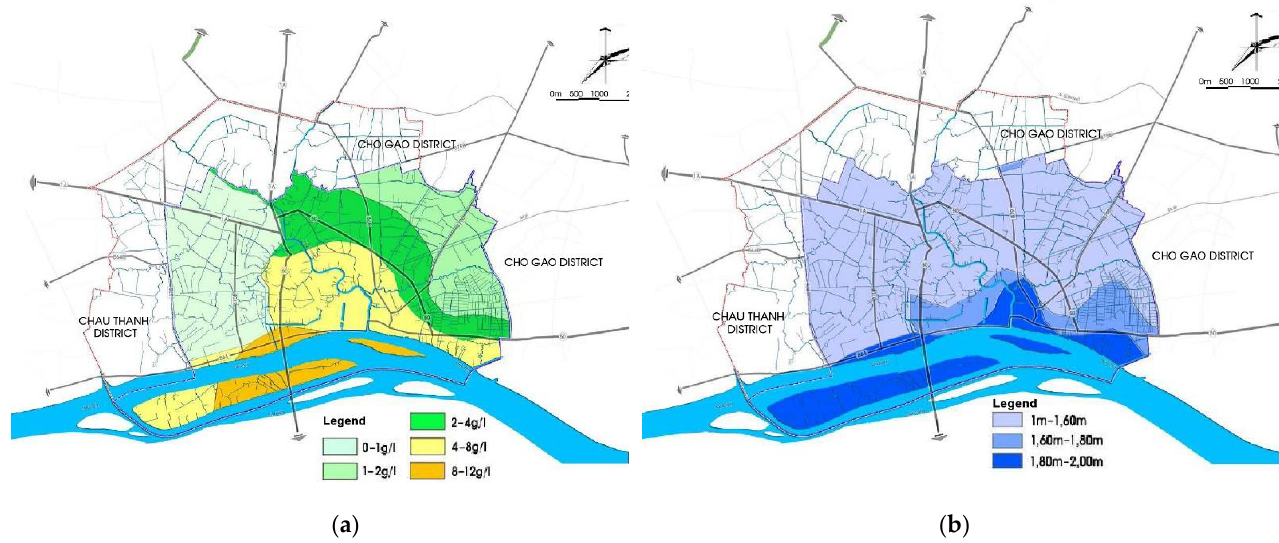
Figure 7. Analysis diagram of saline intrusion ( a ) and flooding ( b ) of My Tho City in a 0.5 m sea-level rise scenario in 2022. Source: Adapted from Institute of Southern Construction Planning, Vietnam (SISP).